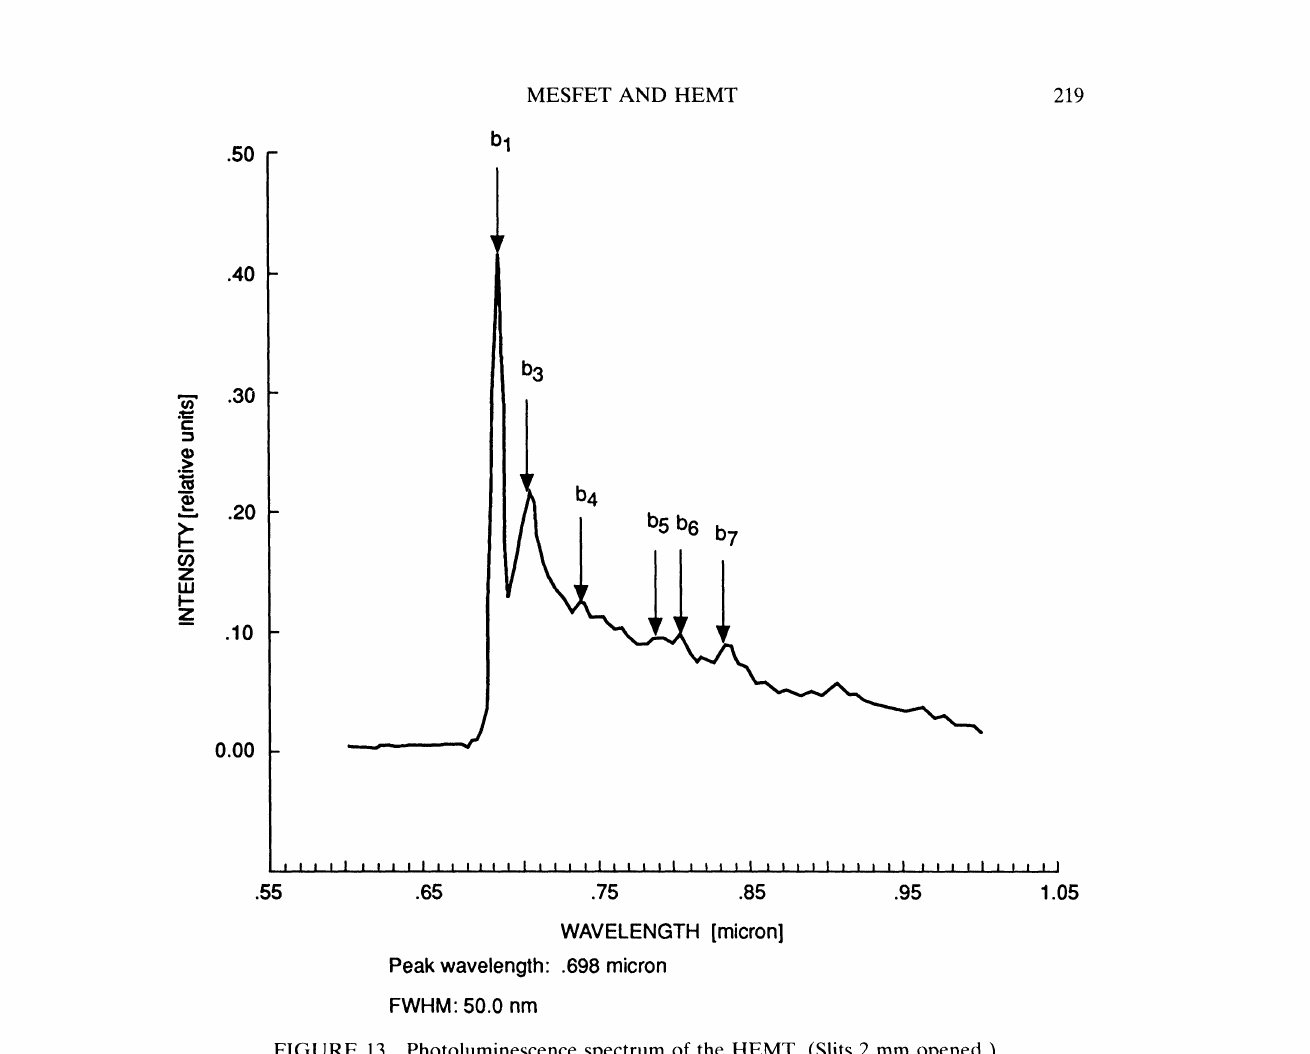
FIGURE 13 Photoluminescence spectrum of the HEMT. (Slits 2 mm opened.)